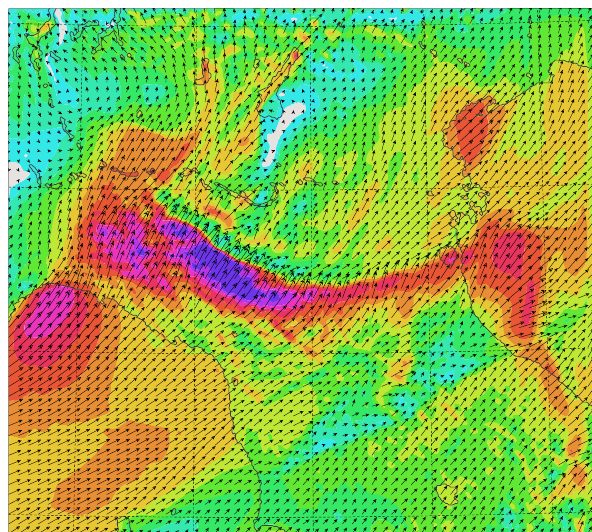
Fig. 5. Accumulated precipitation between 09:00 and 09:30UTC. Contour interval 2.5mm, starting from 0.5 to remove the noisy zero contour.